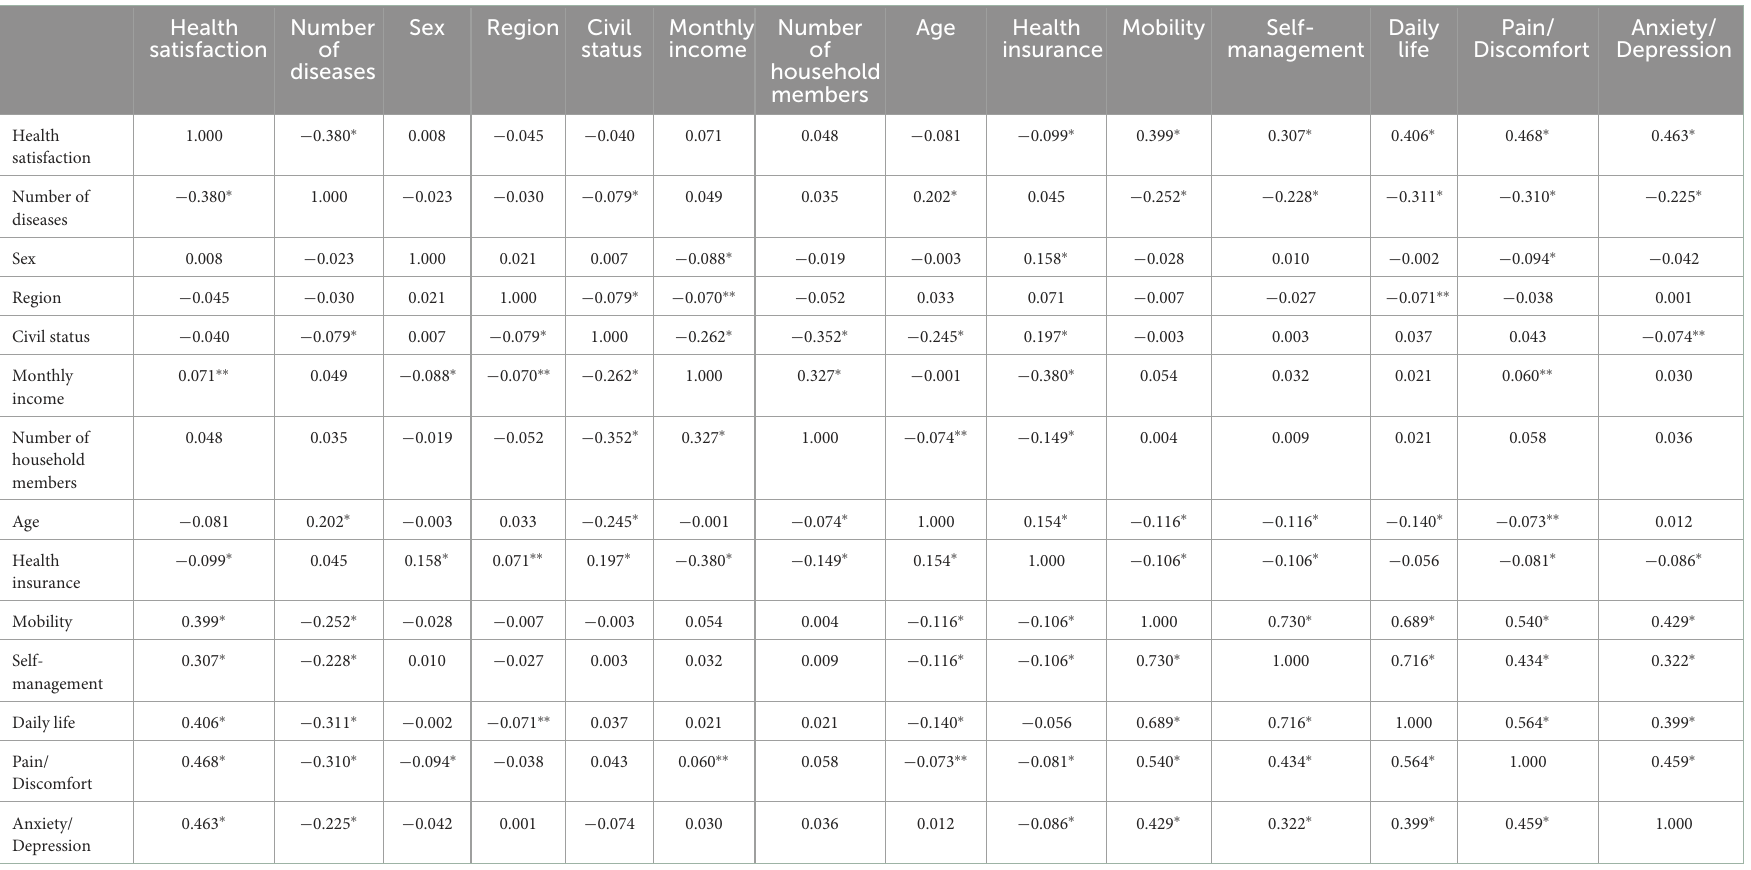
TABLE 3 Correlation